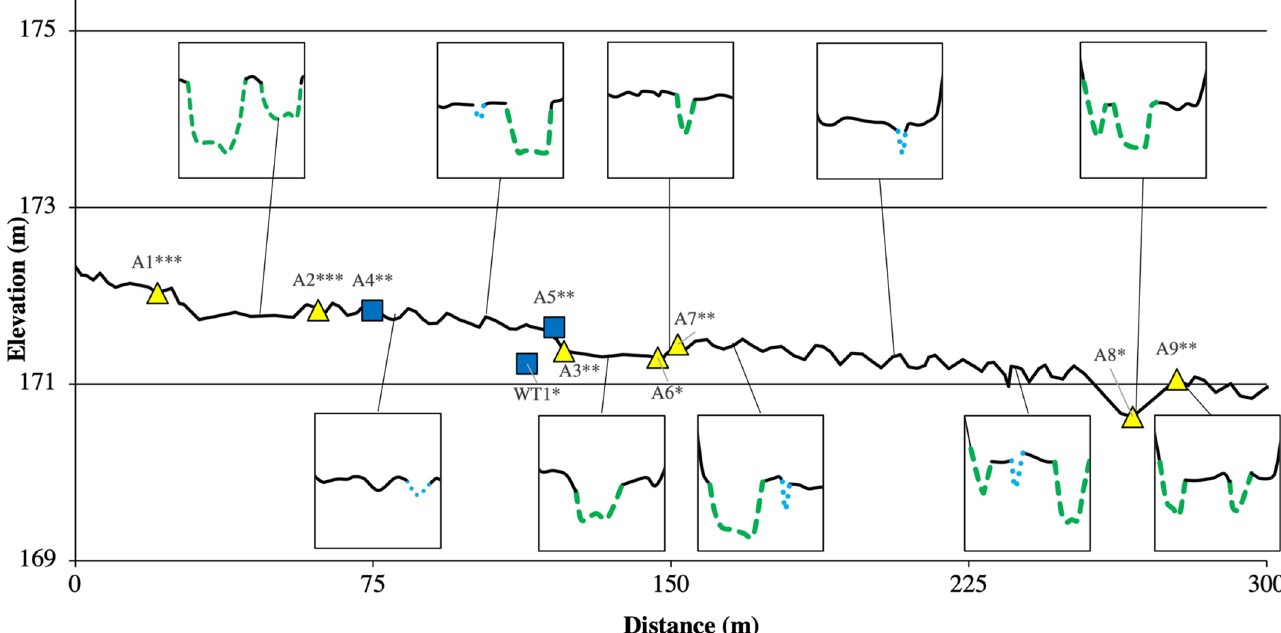
Figure 2. Longitudinal profile of the channel bed along the thalweg from upstream (left) to down- stream (right). The thick black line denotes the channel bed along the thalweg. The thin black lines denote the intersection of each cross section with the main channel at the thalweg. Sensors located on the main channel are denoted by yellow triangles and sensors within the floodplain are denoted by dark-blue squares. Asterisk (*) suffixes denote sensors at features where flow was slower (e.g., pools), double asterisk (**) suffixes denote sensors at stations adjacent to slower flow (e.g., downstream of a pool), and triple asterisk (***) suffixes denote senor locations where flow was more efficiently conveyed (e.g., confined channels, minimal in-stream vegetation). The inset graphs show corridor cross sections, wetlands (within the floodplain and main channel) are denoted by a green dashed line and the main channel is denoted by a dotted light-blue line. Vertical exaggeration is 23.